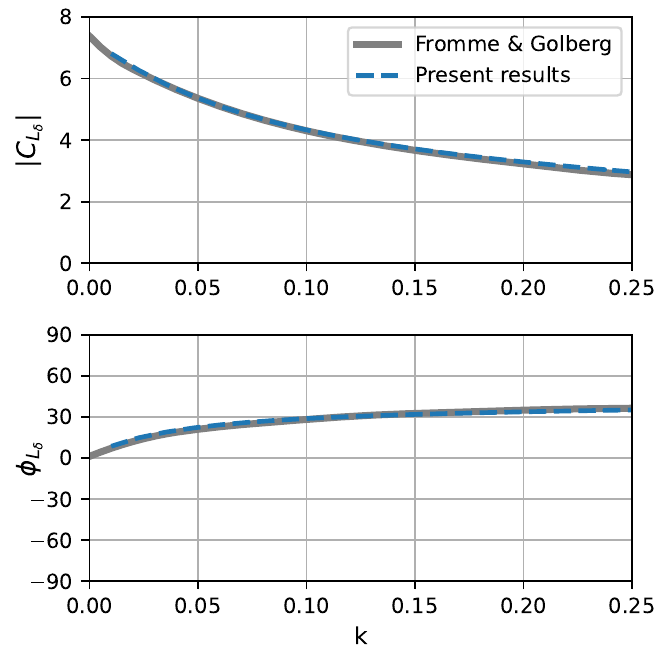
Figure 4. Module and phase of the lift coefficient vs. reduced frequency for an airfoil with a rotating control surface at 3/4 chord.